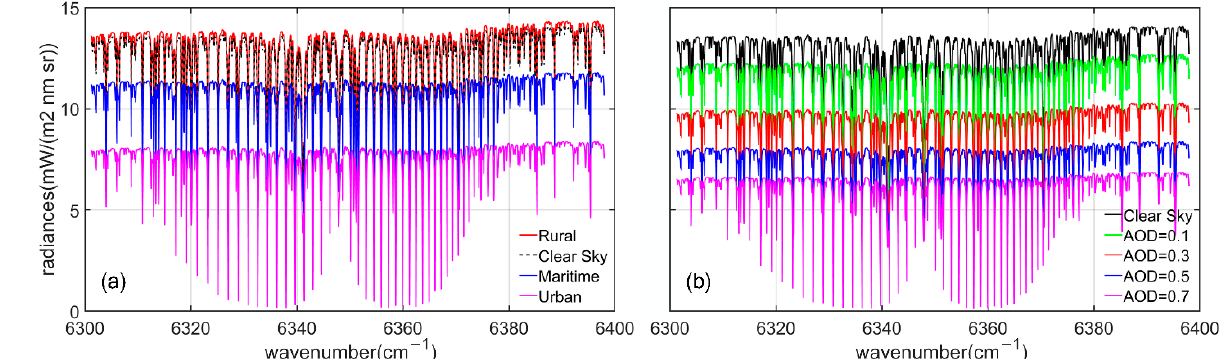
Figure 2. Radiance distribution influenced by aerosols of different types and AOD at HGMS’s weak CO 2 absorption band. ( a ) CO 2 absorption spectrum in the clear sky, urban, marine, and rural aerosols; ( b ) CO 2 absorption spectrum with different AOD under urban aerosol scene.